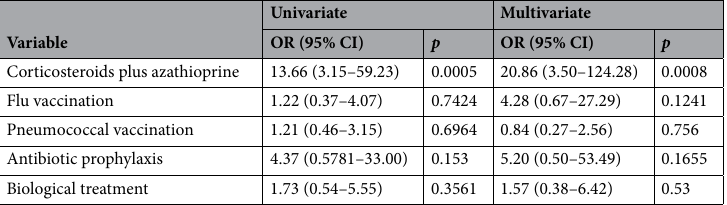
Table 4. Logistic regression model for respiratory infection